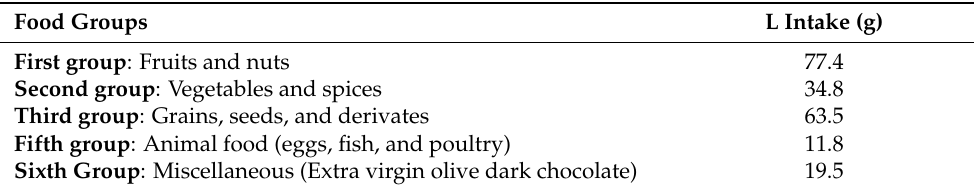
Table 6. Lipid intake by food